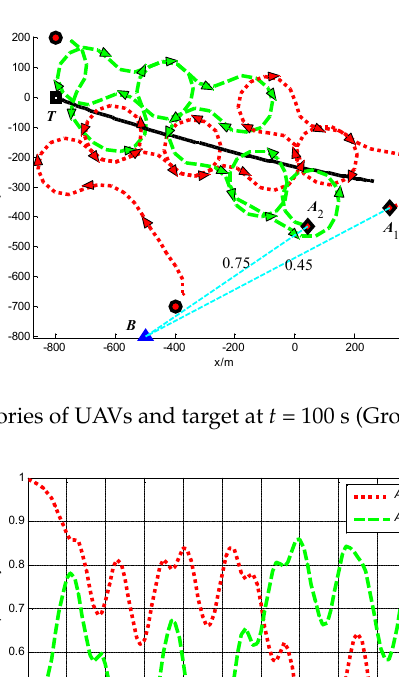
Figure 13. Trajectories of UAVs and target at t = 64 s (Group B in Scenario 1).